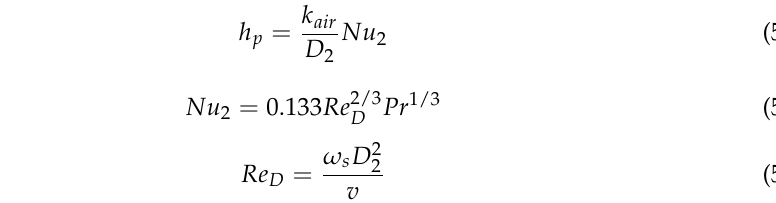
Table 3. The steady-state temperature of the YASA machine.